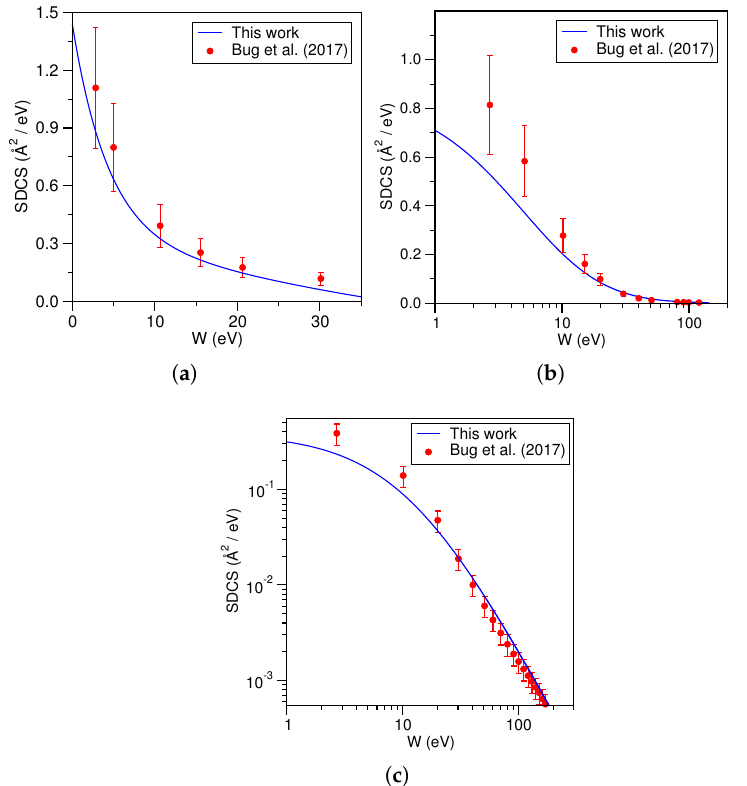
Figure 11. Electron-impact SDCS for THF at a primary electron energy of ( a ) T = 80 eV, ( b ) T = 300 eV, and ( c ) T = 1000 eV. The solid lines are the present results, and the filled circles are the experimental points derived by Bug et al.